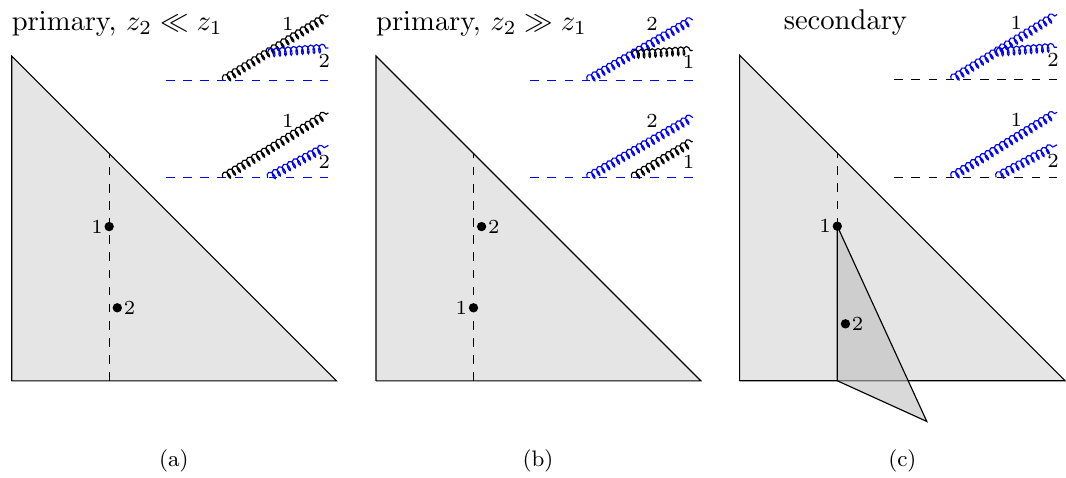
Figure 1. Schematic representation of the three kinematic configurations affected by clustering logarithms. We consider two consecutive declusterings T Lund sequence. If T is reconstructed as “primary” (i.e. in the same plane as T 2 much softer (case (a)) or much harder (case (b)) than T T 2 is reconstructed as a secondary emission from T 1 , and hence can be considered much